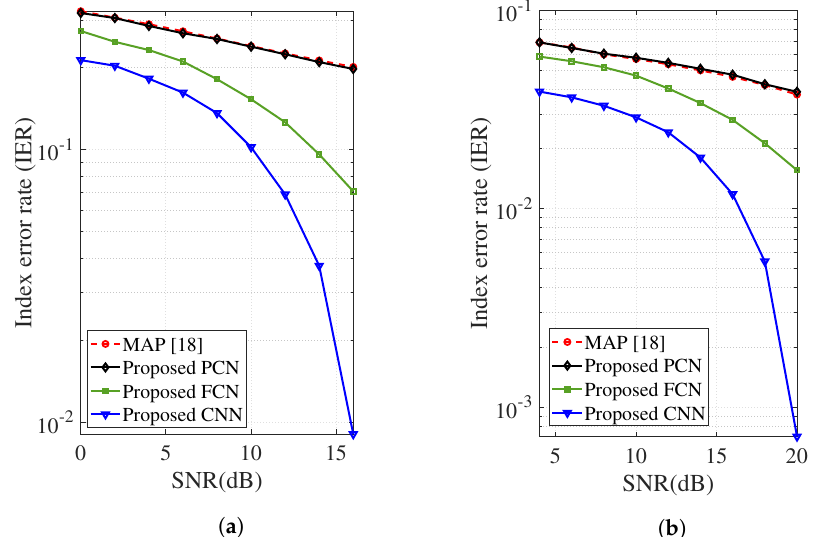
Figure 3. Comparison of IER: ( a ) Case 1 and ( b ) Case 2.